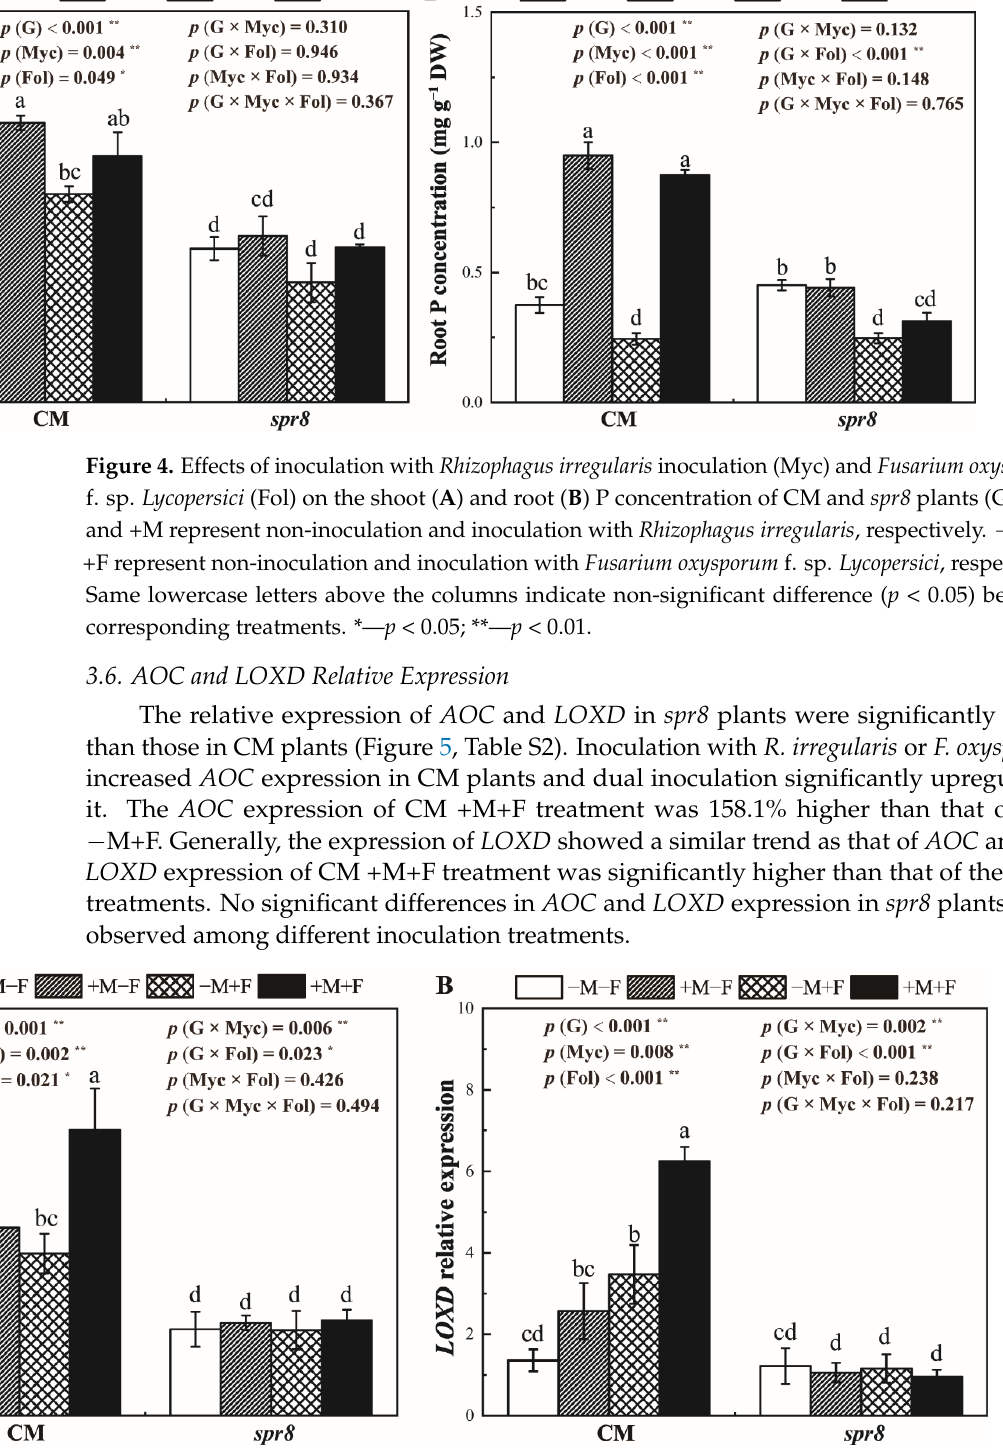
Figure 5. Effects of inoculation with Rhizophagus irregularis inoculation (Myc) and Fusarium oxysporum f. sp. Lycopersici (Fol) on the relative expression of AOC ( A ) and LOXD ( B ) of CM and spr8 plants (G). − M and +M represent non-inoculation and inoculation with Rhizophagus irregularis , respectively. − F and +F represent non-inoculation and inoculation with Fusarium oxysporum f. sp. Lycopersici , respectively. Same lowercase letters above the columns indicate non-significant difference ( p < 0.05) between corresponding treatments. *— p < 0.05; **— p < 0.01.